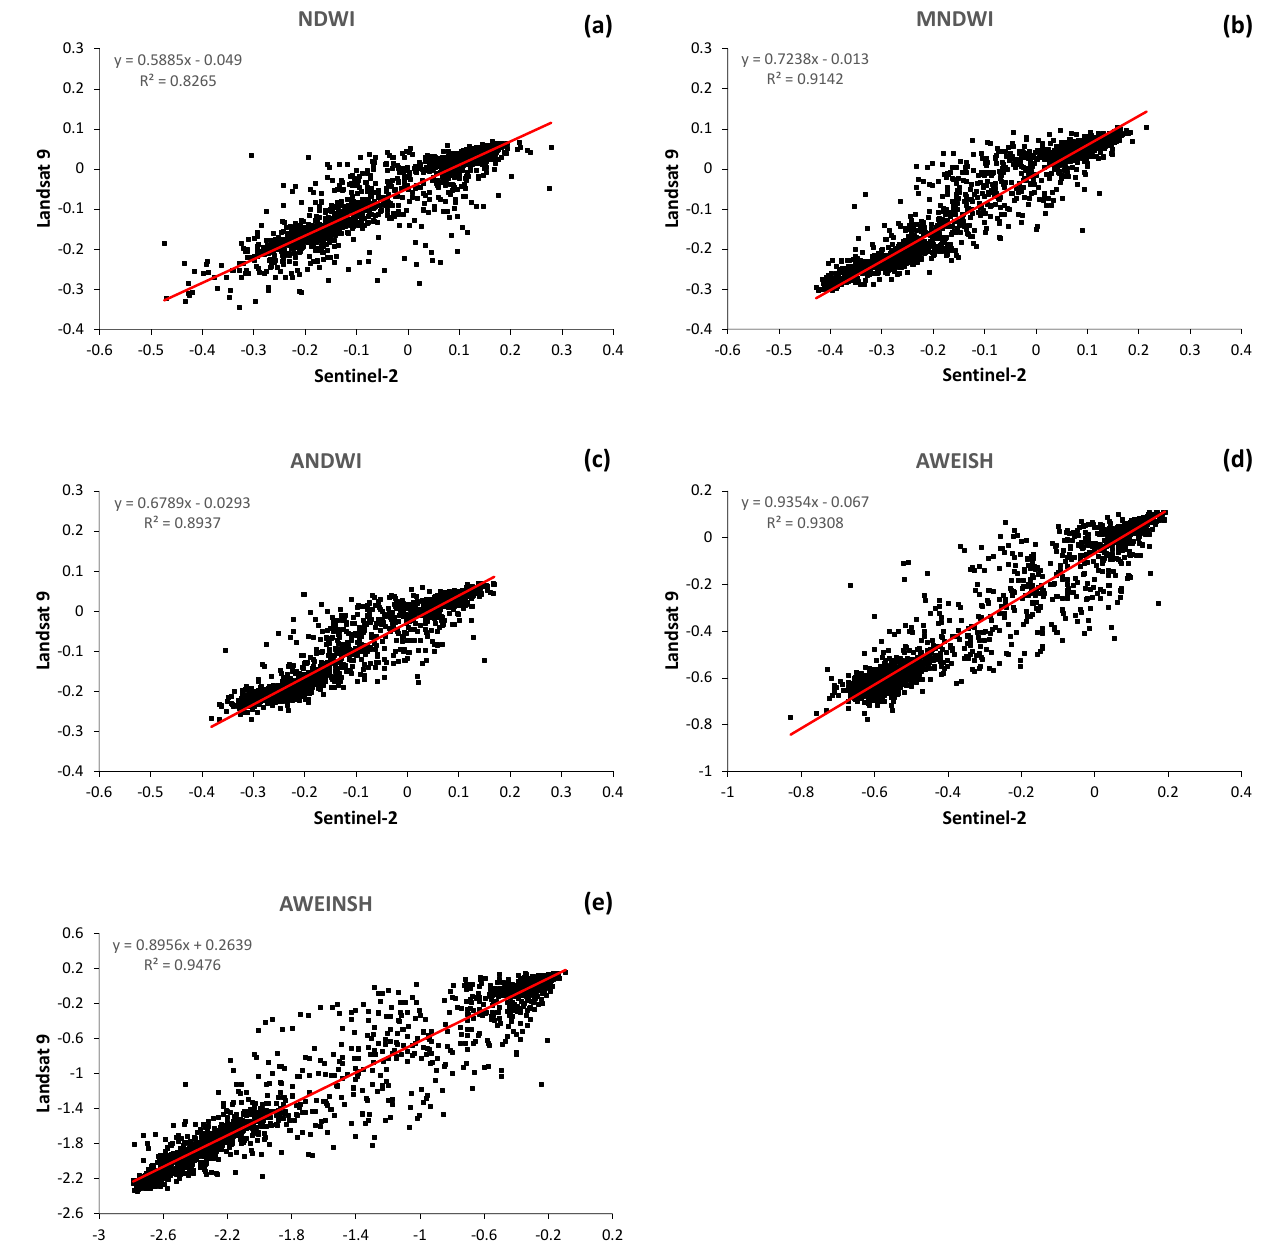
Figure 6. Correlation analysis of pixel=based water index values calculated from Sentinel-2 and Landsat 9 imagery: ( a ) NDWI; ( b ) MNDWI; ( c ) ANDWI; ( d ) AWEIsh; and ( e ) AWEInsh. The corresponding linear regression lines, equations, and correlation coefficients are